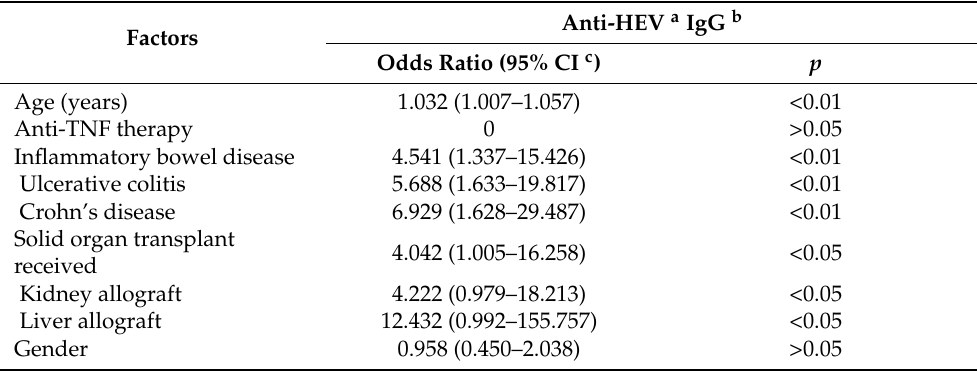
Table 4. Odds ratios of anti-HEV IgG positivity. Healthy control was used as a reference when calculating ORs in IBD and SOT recipient